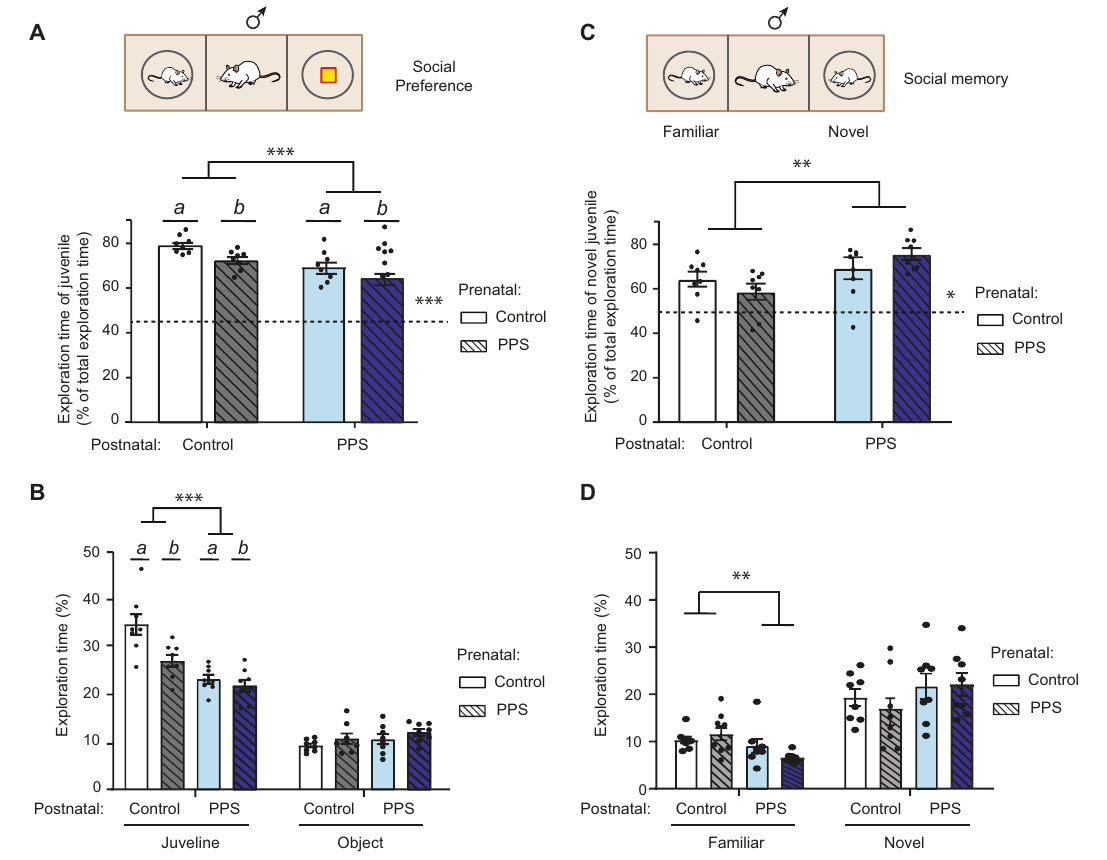
Fig. 3 Offspring of PPS males show a lower inclination for social contact. A Social Preference. The exploration percentage (expressed as the time spent exploring the juvenile over total exploration) was signi fi cantly reduced both by being born to or reared by PPS male-paired dams. Prenatal effects are depicted by letters a, b. B The total time spent exploring the juvenile was signi fi cantly reduced by both prenatal and postnatal effects, while there was no effect on object exploration time. Prenatal effects are depicted by letters a, b. C Social memory. Social memory was enhanced in pups raised by PPS male-paired dams as evident by greater novel juvenile exploration percentage when compared to total exploration time. D The effect in social memory was driven by decreased exploration of the familiar juvenile by offspring raised by PPS male-paired dams, with no changes in exploration of the novel juvenile. n = 8 per group. The results are the mean ± s.e.m. PPS: Peripubertally stressed rats. * P < 0.05, ** P < 0.01, *** P <